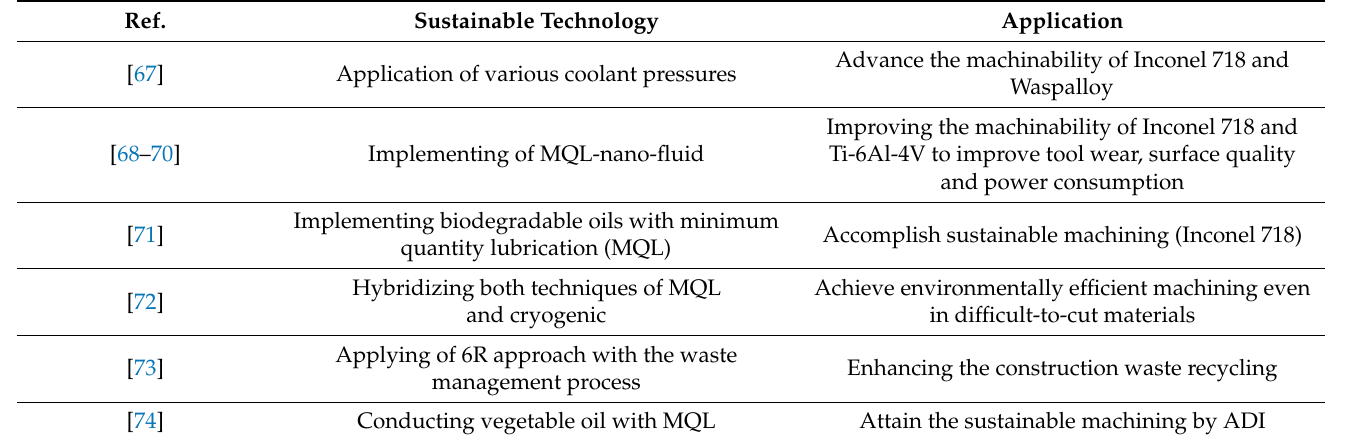
Table 1. Sustainable technology in conjunction with its application.